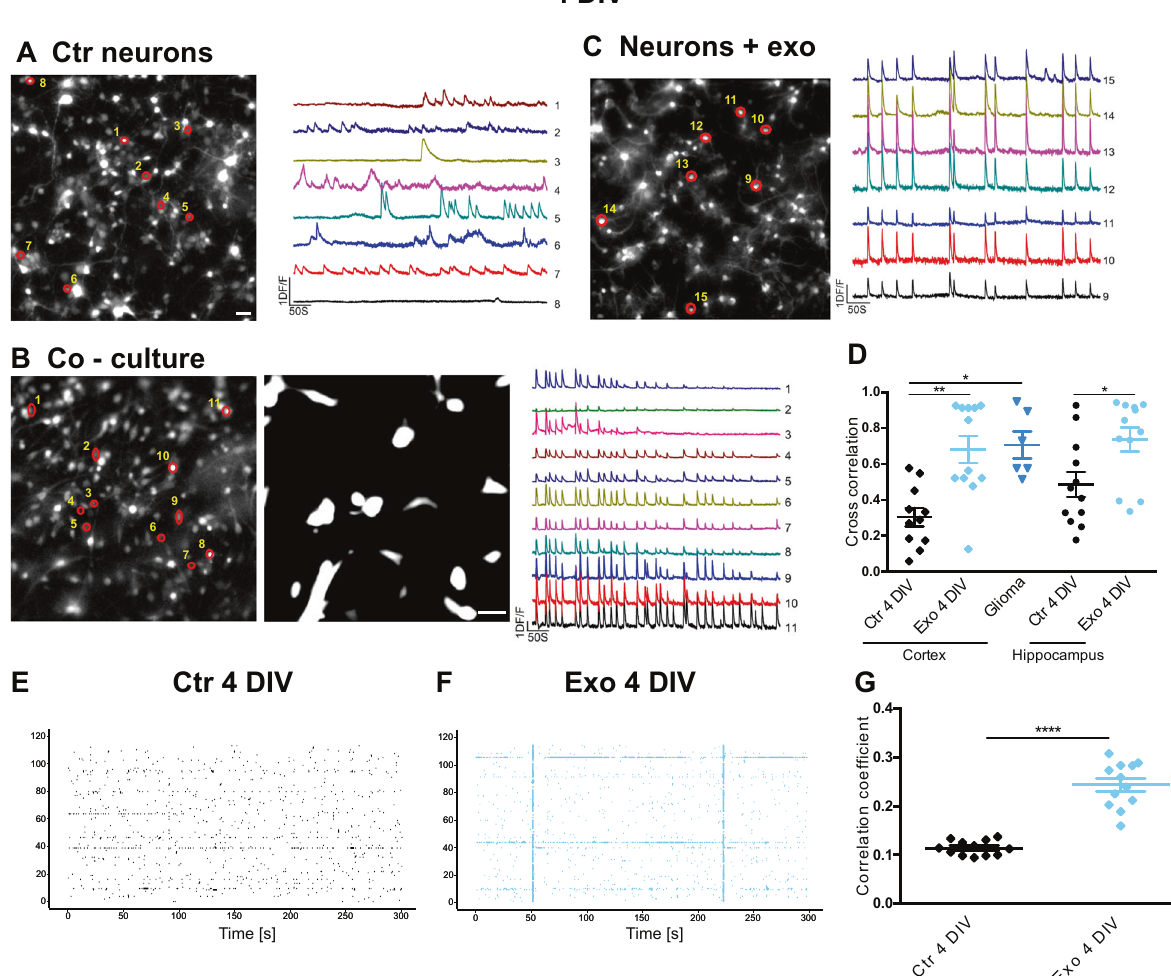
Fig. 1 Glioma cell-derived exosomes induce network synchrony in young (DIV 4) primary neuron cultures. A – C Representative images of Fluo-4 loaded 3 DIV control cortical neuron cultures ( A ), of cultures co-cultured for 1 day with U87, mCherry expressing, glioma cells ( B ), and of cultures exposed for 1 day to U87-derived exosomes ( C ). ROIs indicate cells from which the representative Ca 2 + traces are extracted. Scale bars, 50 µm. D Cross-correlation values of the various experimental groups. Data are shown as average ± standard error; statistically signi fi cant differences were assessed with the Wilcoxon – Mann – Whitney U test (to compare two groups) or Kruskal – Wallis test followed by Dunn ’ s multiple comparison post hoc test (to compare more than two groups); ** p < 0.01, *** p < 0.001; n = 3 independent cell preparations, four coverslips for each preparation were analyzed and reported as superimposed individual points. E Representative raster plots of spike times simultaneously detected at 120 spatial locations (channels) by substrate-integrated MEAs: channels ’ numbers are indicated on the y -axis. The spiking activity is displayed over a representative time window of 5 min, preceding the exposure to U87 exosomes (Ctr). F Representative recording of the same neuronal culture in ( E ) after 24 h of exosome exposure (Exo): the occurrence of network bursts is visible in the raster plot as vertical “ stripes ” spanning the entire MEA surface. Bursts are representative of the degree of synchrony of the network. G Pearson correlation coef fi cients among spike times from different channels over 15 min recordings. The average correlation values across 10 channels were analyzed and their distributions were compared under control conditions and after exosome, exposure using the Wilcoxon – Mann – Whitney test; *** p < 0.001; n = 12 MEAs, an average of 10 channels for each